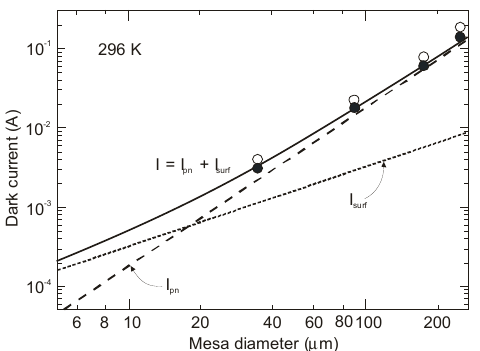
Figure 36. Total dark current at a reverse bias of 0.1 V ( • ) and 0.2 V ( ○ ) in InAsSbP/InAs 0.7 Sb 0.3 DH photodiode at room temperature. The lines present the simulated bulk ( I pn ) and surface ( I surf ) leakage currents as well the sum of the above two currents at a reverse bias of 0.1 V (after [126]).